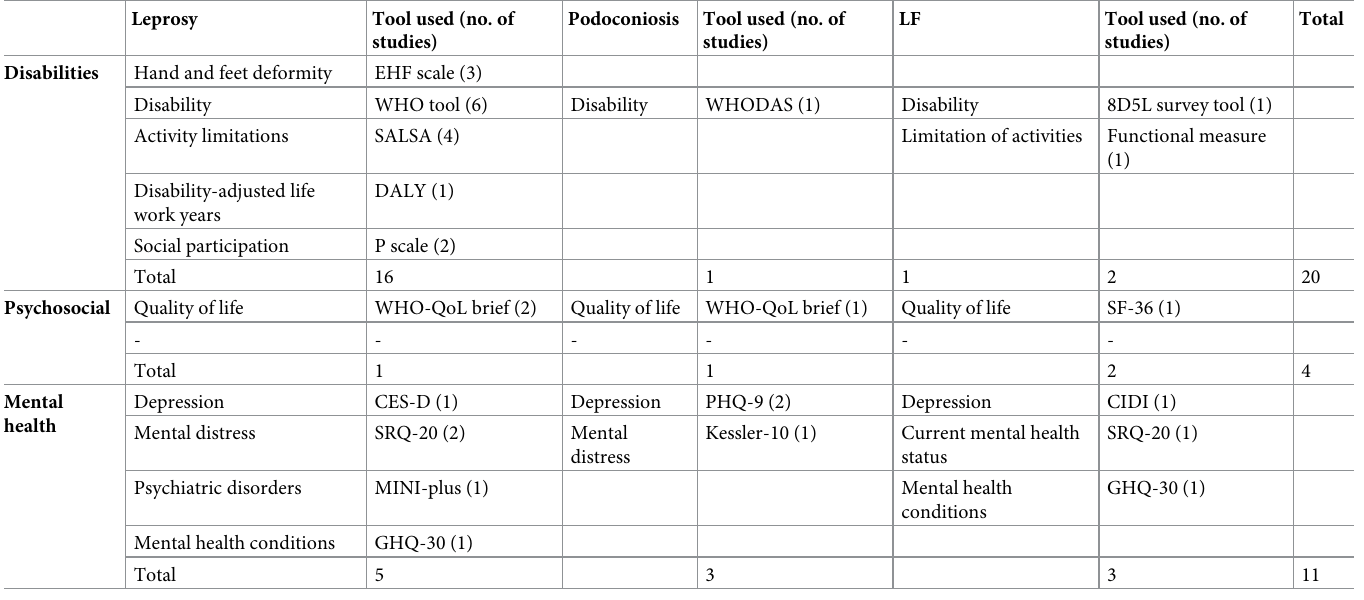
Table 1. Profile of the disability, psychosocial, and mental health outcomes found among those affected by leprosy, podoconiosis, and LF and the outcome measures used in the studies. Leprosy Tool used (no. of